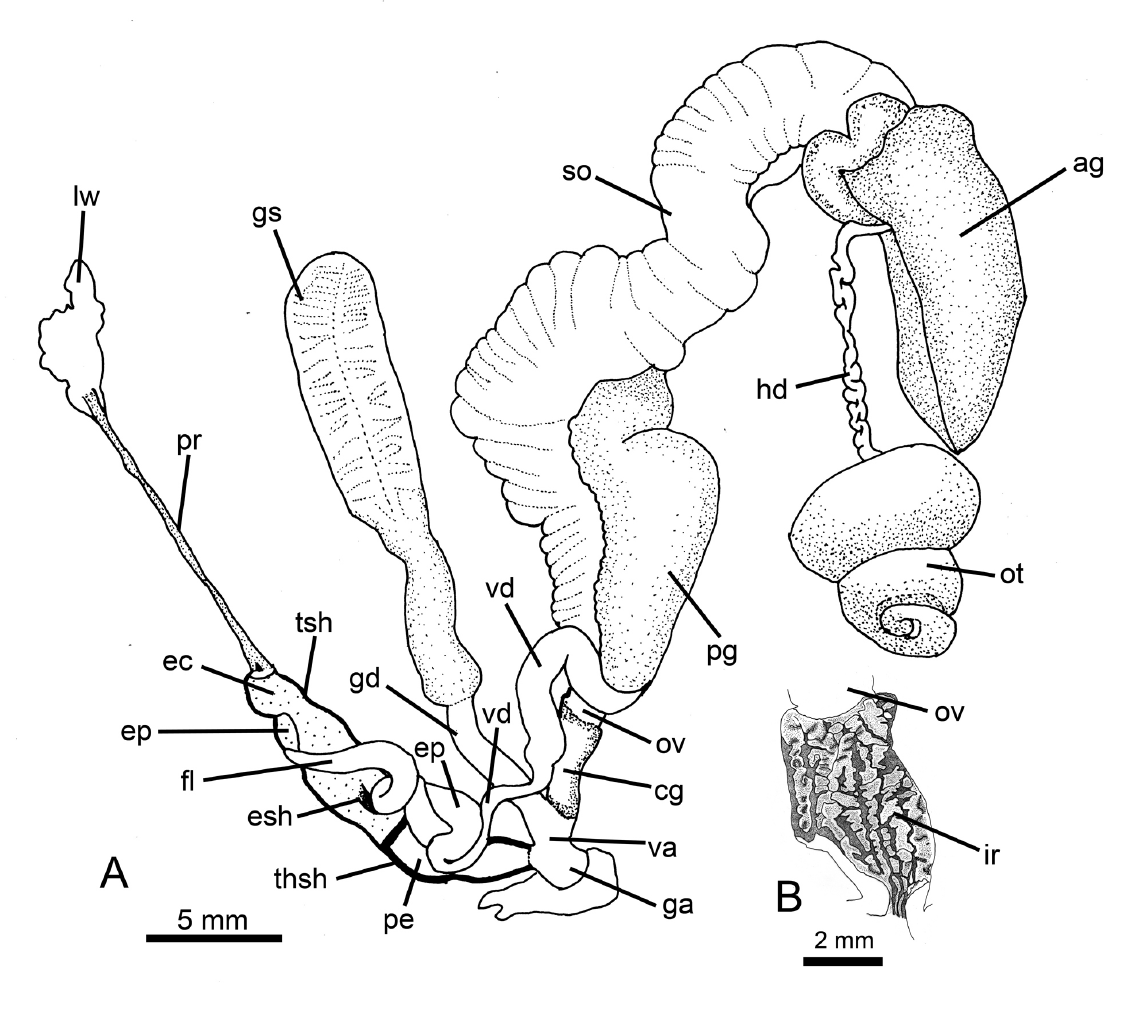
Fig. 8. Reproductive system of the holotype (BNHS GAS 113) of Varadia amboliensis Bhosale, Thackeray, Muley & Raheem gen. et sp. nov. A . Gross morphology. B . Dissection of capsular gland, showing morphology of inner wall. Abbreviations: ag = albumen gland; cg = capsular gland; ec = epiphallic caecum; ep = epiphallus; esh = extension of penial sheath around epiphallus; fl = flagellum; ga = genital atrium; gd = gametolytic duct; gs = gametolytic sac; hd = hermaphrodite duct; ir = irregularly-marked papillate ridges; lw = lung wall; ot = ovatestes; ov = oviduct; pe = penis; pg = prostate gland; pr = penial retractor muscle; thsh = thick penial sheath; tsh = thin penial sheath; so = spermoviduct; va = vagina; vd = vas